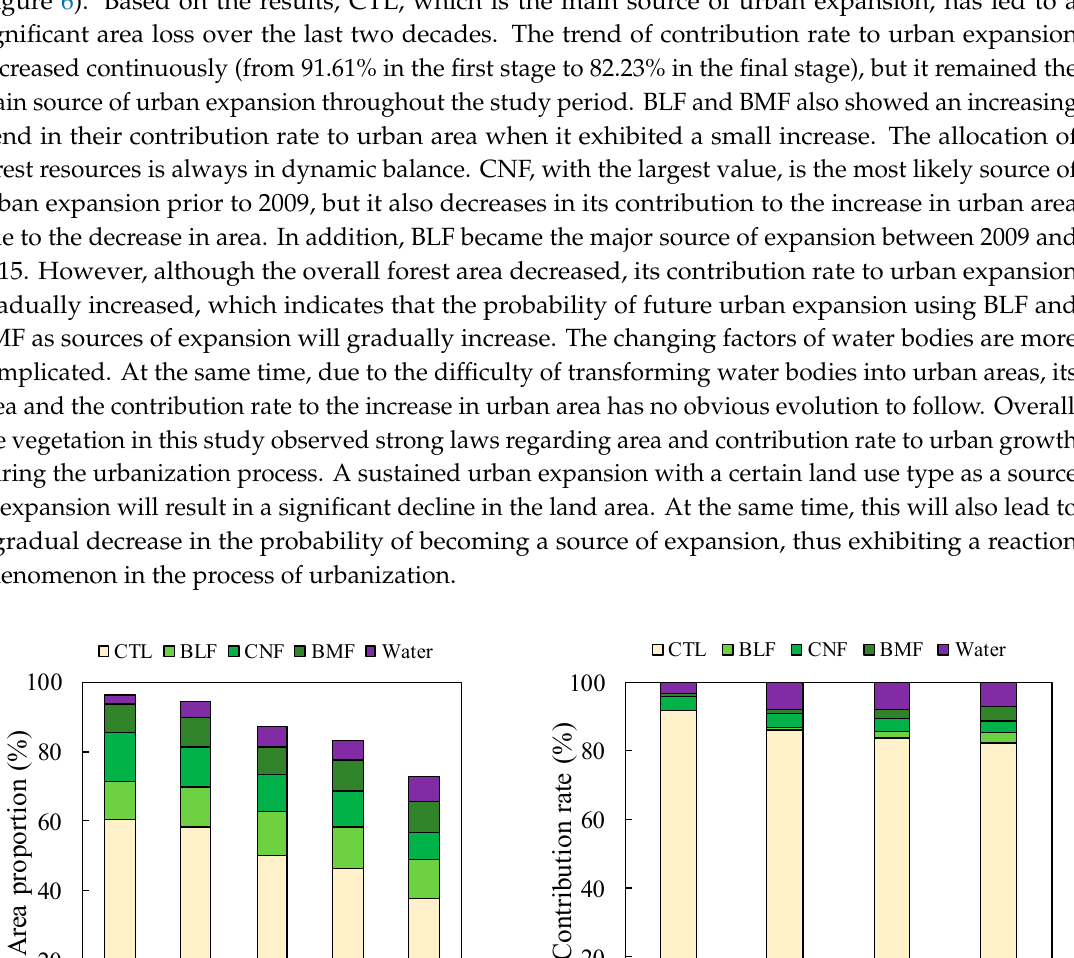
Figure 5. Spatiotemporal distribution of urban growth in Hangzhou ( A ), Jiaxing ( B ) and Huzhou ( C ) from 1995 to 2015.